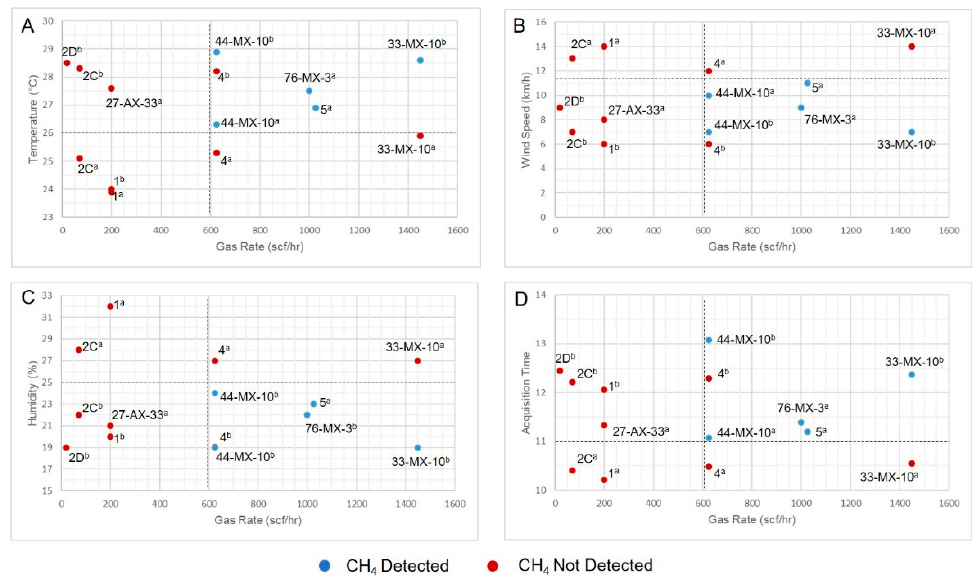
Figure 3. Metrics of ambient conditions—( A ) temperature, ( B ) wind speed, ( C ) humidity, ( D ) acquisition time—versus gas rate during the SEBASS airborne survey for each gas station (named on the plots). Superscript letters after gas station names correspond to acquisition altitudes at (a) = 457 m and (b) 762 m. Dashed lines limit the quadrants where temperature, wind speed, humidity, and acquisition time favored the detection of CH 4 plumes in the experiment. Table 2. Detection of CH 4 plumes in the MWIR and LWIR ranges. Superscript letters indicate the image acquisition altitude at (a) 457 m and at (b) 762 m. (cid:51) = CH 4 plume detected/x = CH 4 plume not detected.